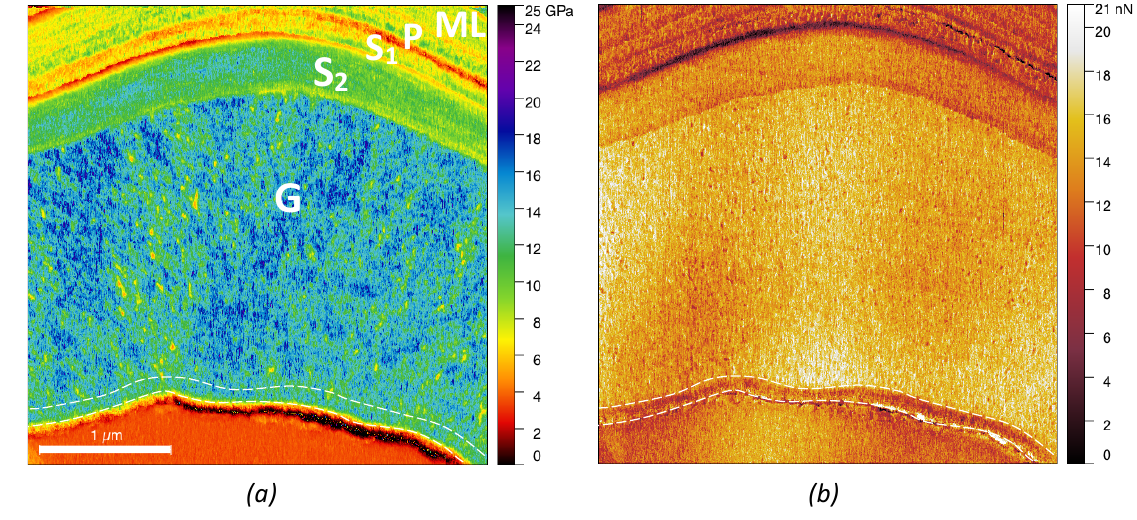
Figure 4 : a) Close-up of the indentation map of a cell taken at a distance of 740 µm from the cambium corresponding to the white box in Fig. 2b, with the associated adhesion map (b), highlights a sub-G-layer with lower adhesion force close to the